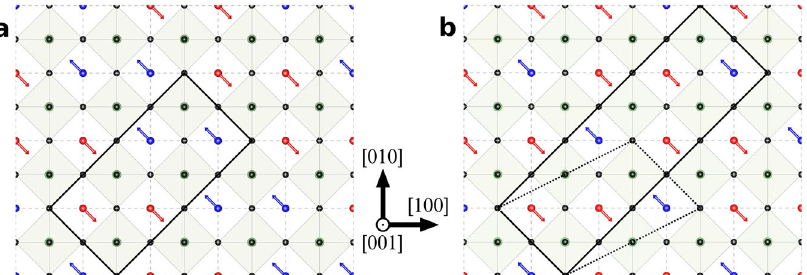
Fig. 2 Schematic Pb displacements in the AFE 40 and FiE phases of PbZrO 3 . Top view of the in-plane displacements of the lead cations in the AFE 40 phase a , and in the FiE phase b . Unit cells marked in black; lead cations marked in red and blue. For the FiE phase a smaller primitive cell (of only 30 atoms) exists, for which the in-plane projection is shown with a dotted line in b (see also Fig. 1). As explained in the text, in b , the two red cations in the primitive cell move by + 0.16 Å and + 0.23 Å, respectively, while the blue cation moves by − 0.21